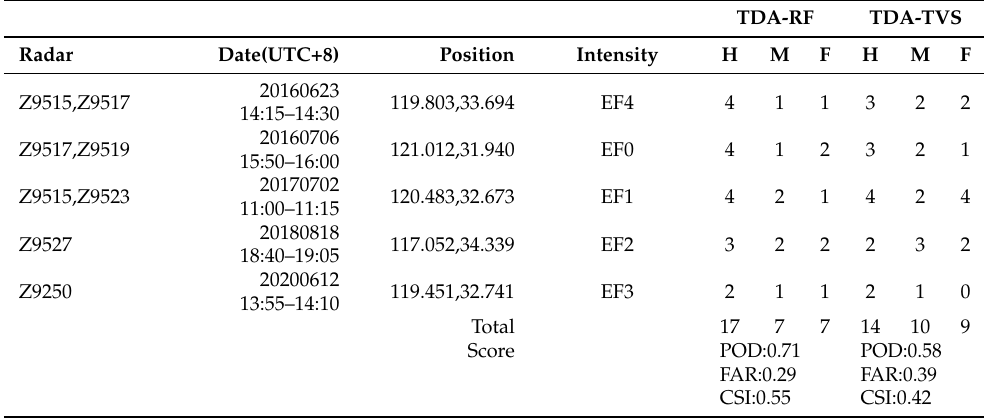
Figure 7. The time window used for scoring the TDA-RF and TDA-TVS. The beginning ( T begin ) and ending ( T end ) times of a tornado event are also indicated. Table 5. TDA-RF and TDA-TVS scores. The position represents latitude and longitude, respectively. H: numbers of hits, M: numbers of misses, F: numbers of false alarms (F). POD = H/(H + M), FAR = F/(H + F), and CSI = H/(H + M +